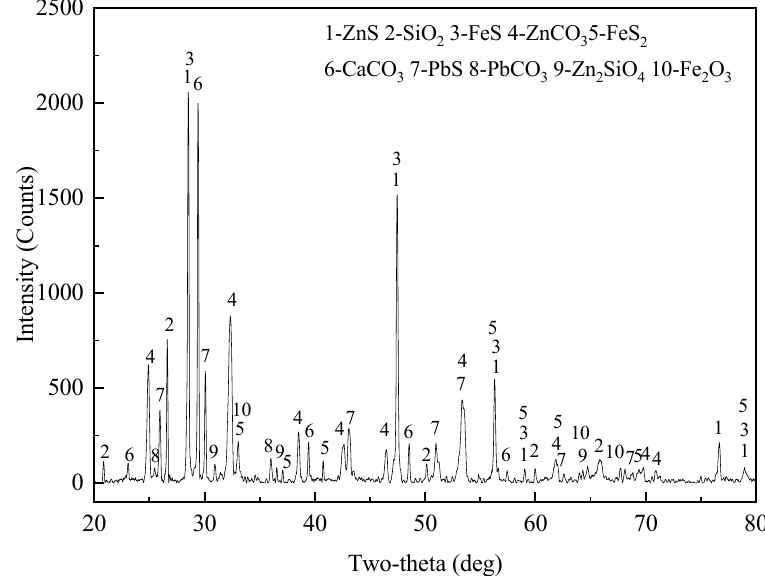
Figure 3. The XRD pattern of complex zinc ore.